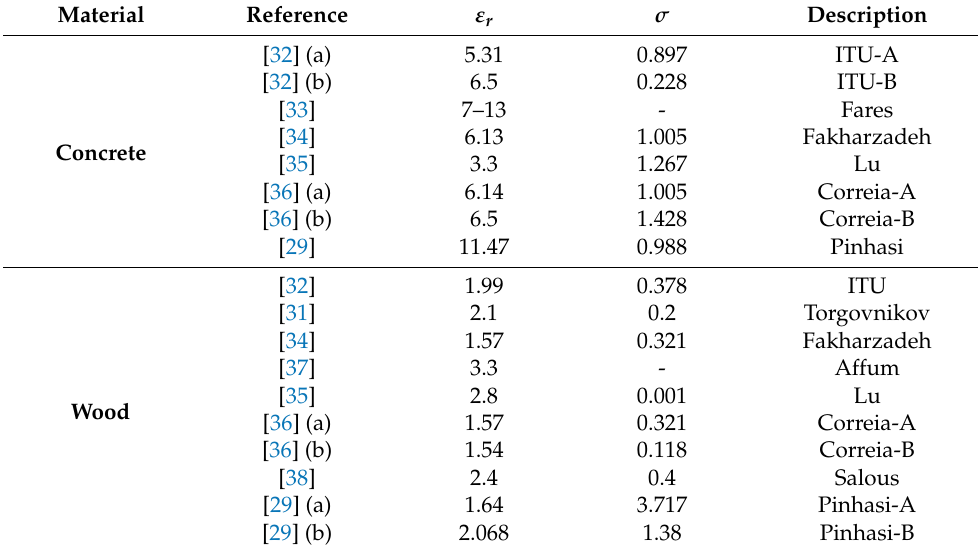
Table 2. Electrical constitutive parameters values for concrete and wood at 60 GHz.